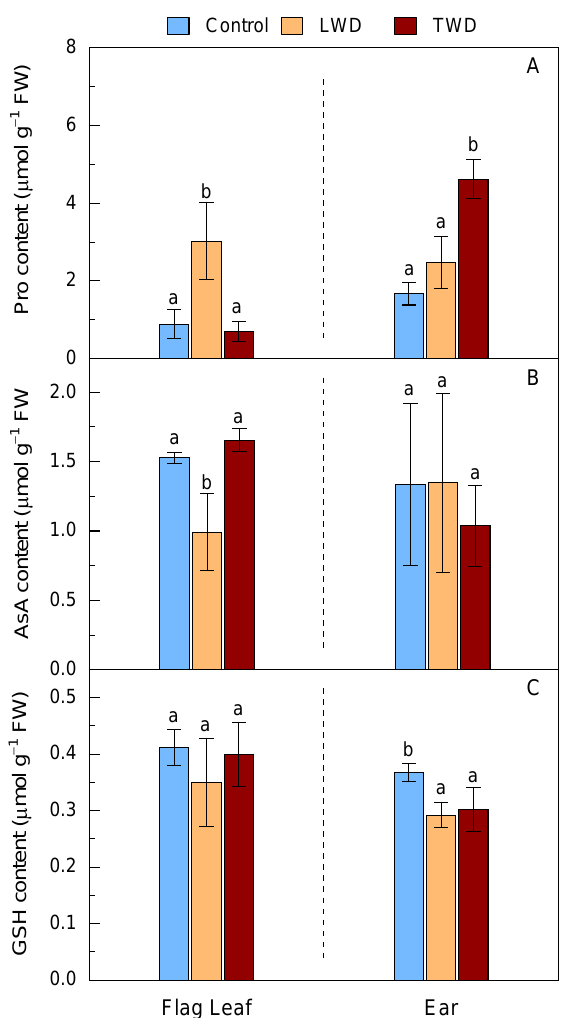
Figure 4. Effect of two water deficit treatments under combined elevated CO 2 and high temperature on Pro (Panel A ), total content of ascorbate (AsA plus DHA) (Panel B ) and total content of glutathione (GSH plus GSSG) (Panel C ) in the flag leaves and ears of potted wheat. Legend is as described in Figure 2. Bars represent mean values ± SD. Different letters above the bars (a and b) indicate statistically significant differences among treatments for each organ after post-hoc test analyses ( p -value ≤ 0.05, n = 4, see Spreadsheet S1, Treatments).